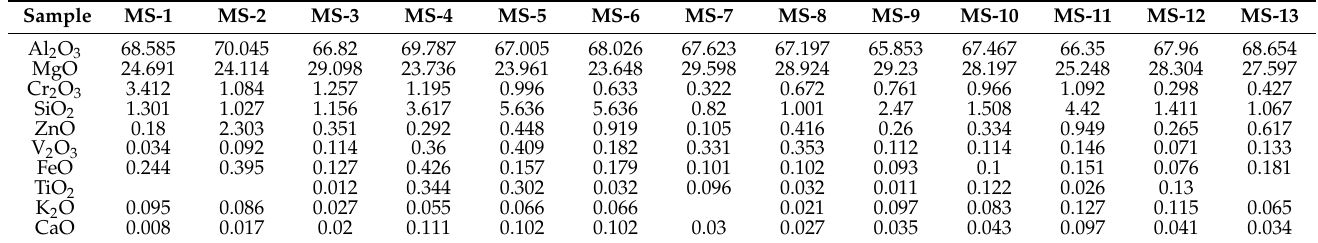
Table 2. EDXRF Chemical fingerprinting of “Jed”’ spinel from Man Sin